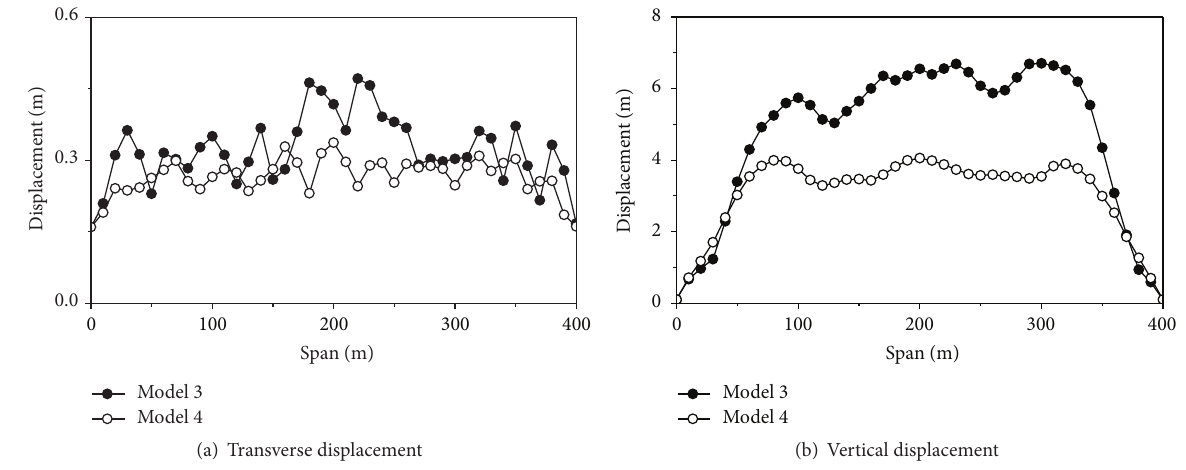
Figure 10: Comparison of the maximum displacements of the transmission lines of two models of the tension type.